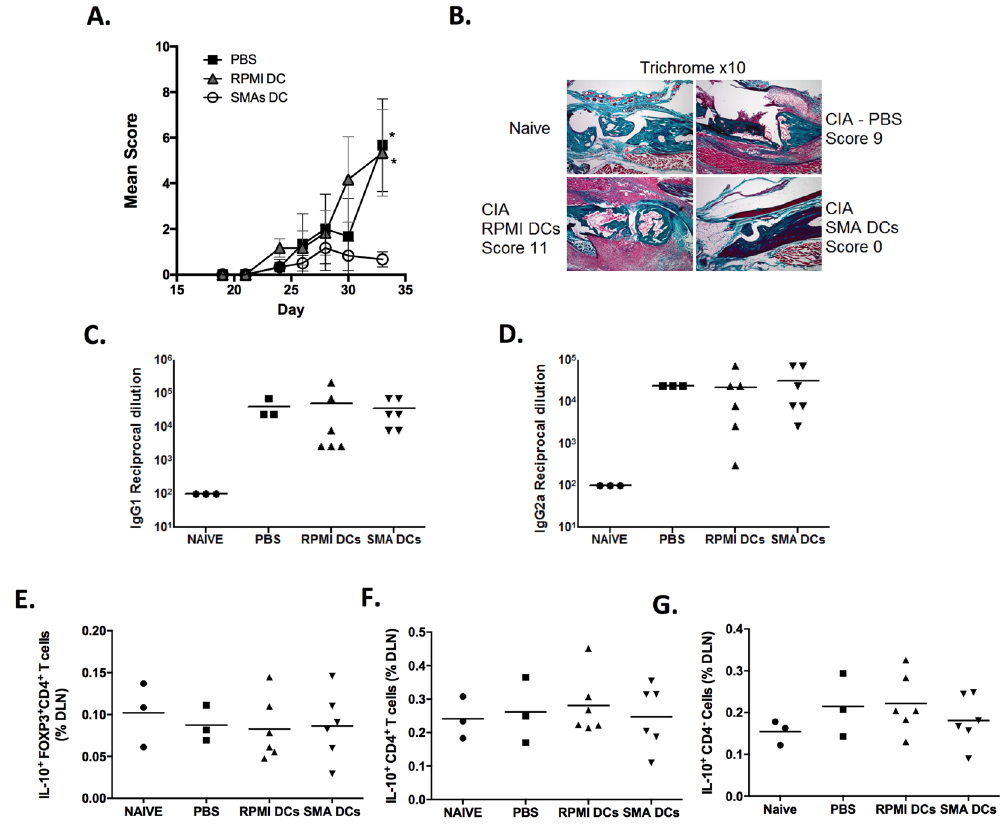
Figure 4. SMA-treated dendritic cells protect against CIA. DBA/1 bmDCs were incubated with SMAs 11a and 12b (2.5 μ g/ml of each) and CII overnight, washed, and injected into CIA-mice on day − 2, 0 and 21. Disease is shown by mean arthritic score ( A ) (PBS, n = 3; RPMI-DCs and SMA-DCs, n = 6). Data are expressed as means ± SEM and analysed using an unpaired t test where * p < 0.05 compared to PBS. Joint sections (x10 magnification) from individual mice representative of each treatment group were assessed for histopathology by Trichrome staining ( B ). CII-specific IgG1 ( C ) and IgG2a ( D ) levels in serum samples from naïve (no CII treatment; n = 3), PBS- (n = 3), RPMI DC- (n = 6) and SMA DC- (n = 6) treated CIA mice were determined by ELISA. Results are expressed as mean (of duplicate determinations) for each mouse in the group. The percentage of IL-10 + FOXP3 + CD4 + T cells ( E ), IL-10 + CD4 + T cells ( F ) and CD4 − IL-10 + cells ( G ) in the DLNs from all paws from CIA-mice treated with PBS, RPMI-DCs or SMA-DCs were analysed by flow cytometry. Results from individual mice in each group are shown; numbers as above. Data were analysed using one-way ANOVA employing Fishers LSD